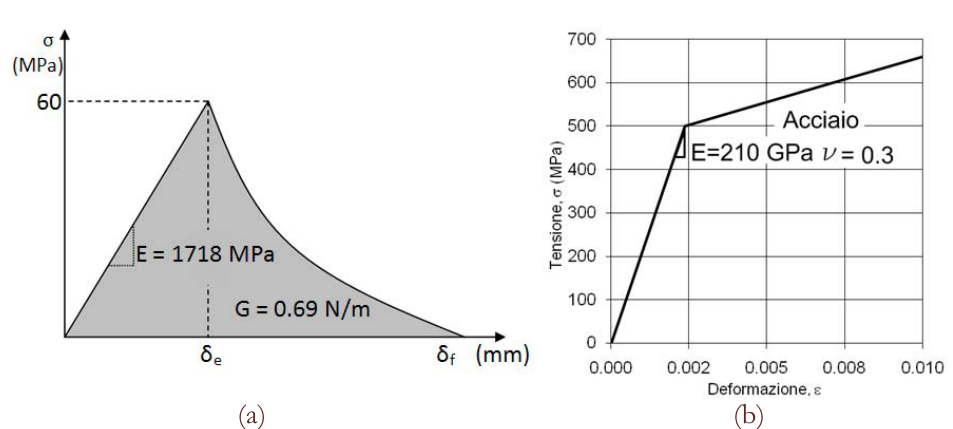
Figura 2: Legame coesivo adesivo (a) e legame costitutivo acciaio elastoplastico